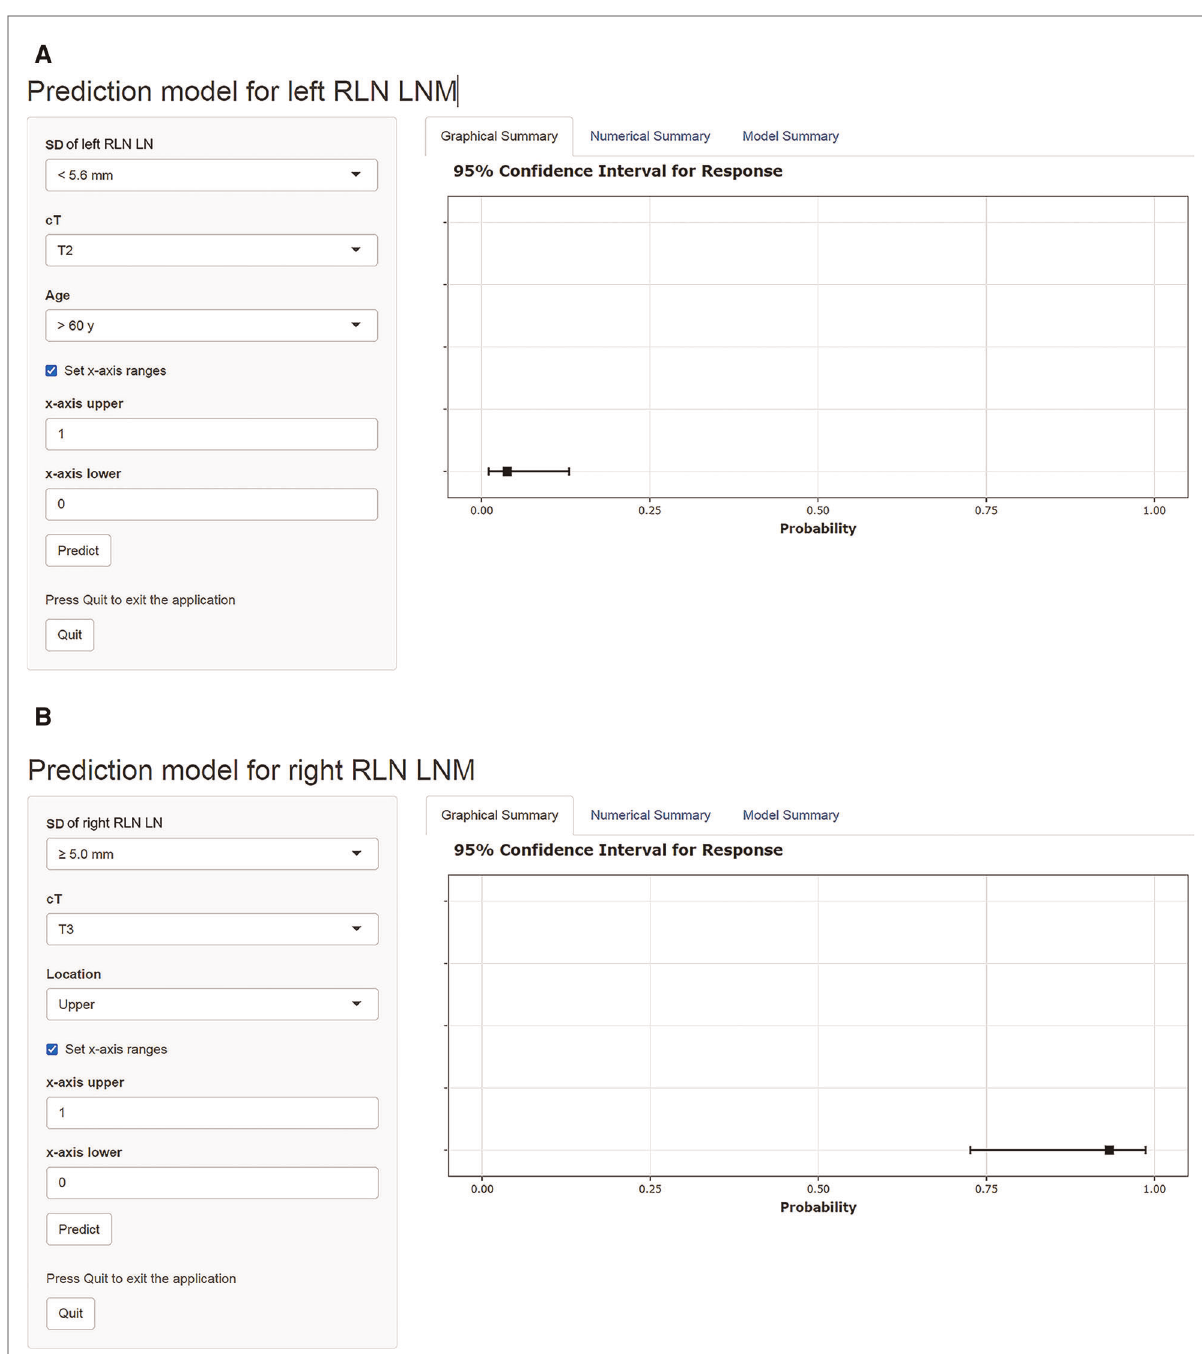
FIGURE 6 Examples of the dynamic nomograms for left and right RLN LNM prediction. The probability of RLN LNM is shown on the right side of the screen after each parameter is entered on the left input fi eld. The risk of left RLN LNM was at 3.8% for a patient with an SD of left RLN LN <5.6 mm, cT2 stage, age >60 years ( A ). A patient diagnosed with an SD of right RLN LN ≥ 5.6 mm, cT3 stage, and upper lesion might suffer right RLN LNM at a risk of 93.3% ( B ). RLN LNM, recurrent laryngeal nerve lymph node metastasis; RLN LN, recurrent laryngeal nerve lymph node; SD, short diameter; cT, clinical T